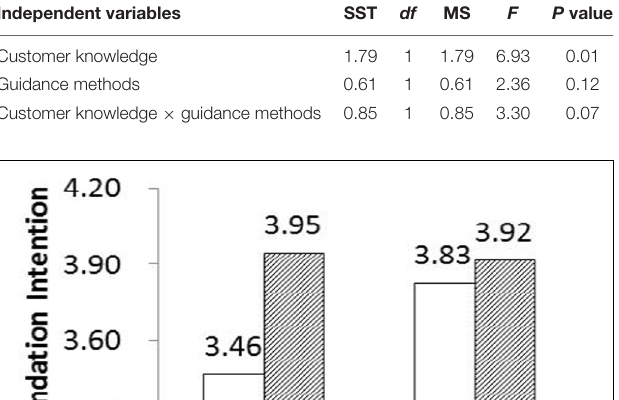
TABLE 6 | Customer knowledge, guidance methods, and their interactions. Independent variables